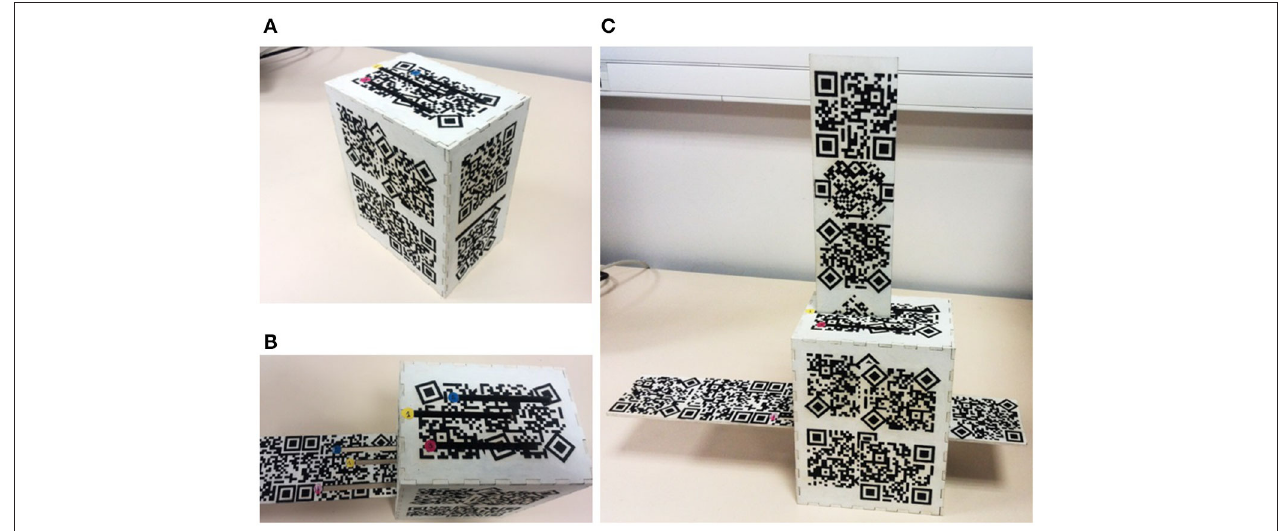
FIGURE 1 | The assembly set-up at different stage of the insertion task. (A) The box before the insertion. (B) The first board during the insertion into the box (operation 1). (C) The second board inserted into the box and the first board (operation